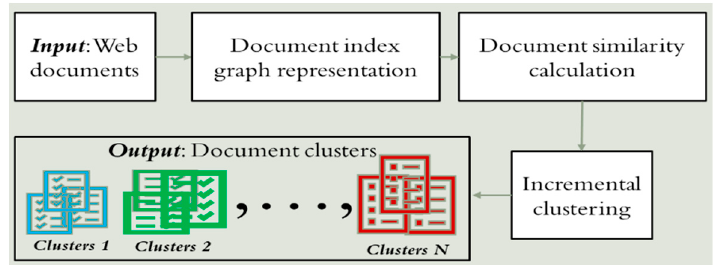
Figure 13. Conceptual overview of web documents clustering.